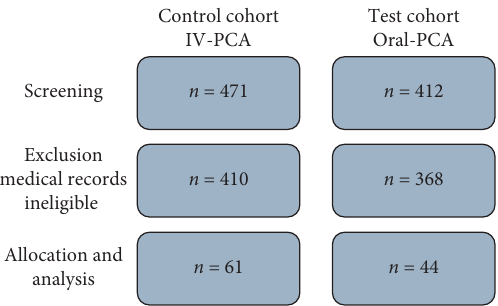
Figure 2: Patient disposition flow